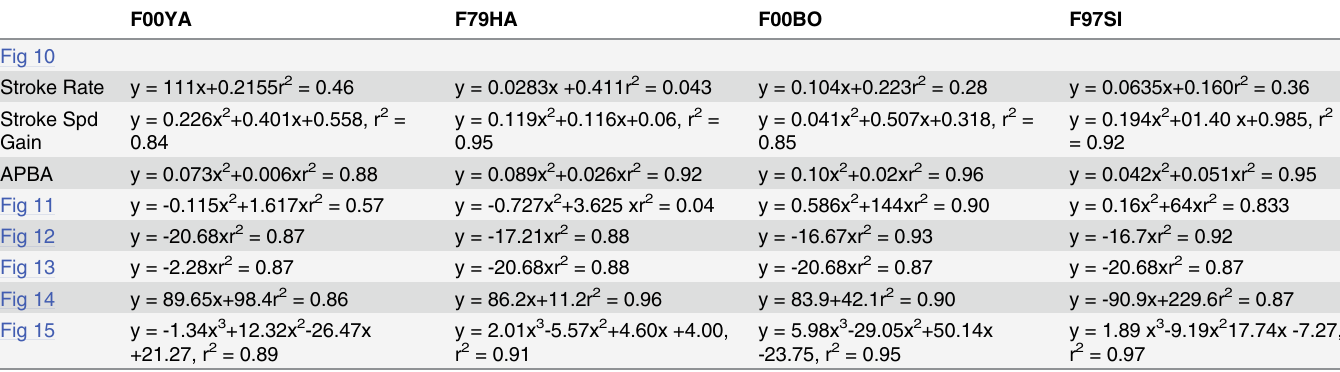
Table 2. Regression equations and r 2 values for all scatter plots.